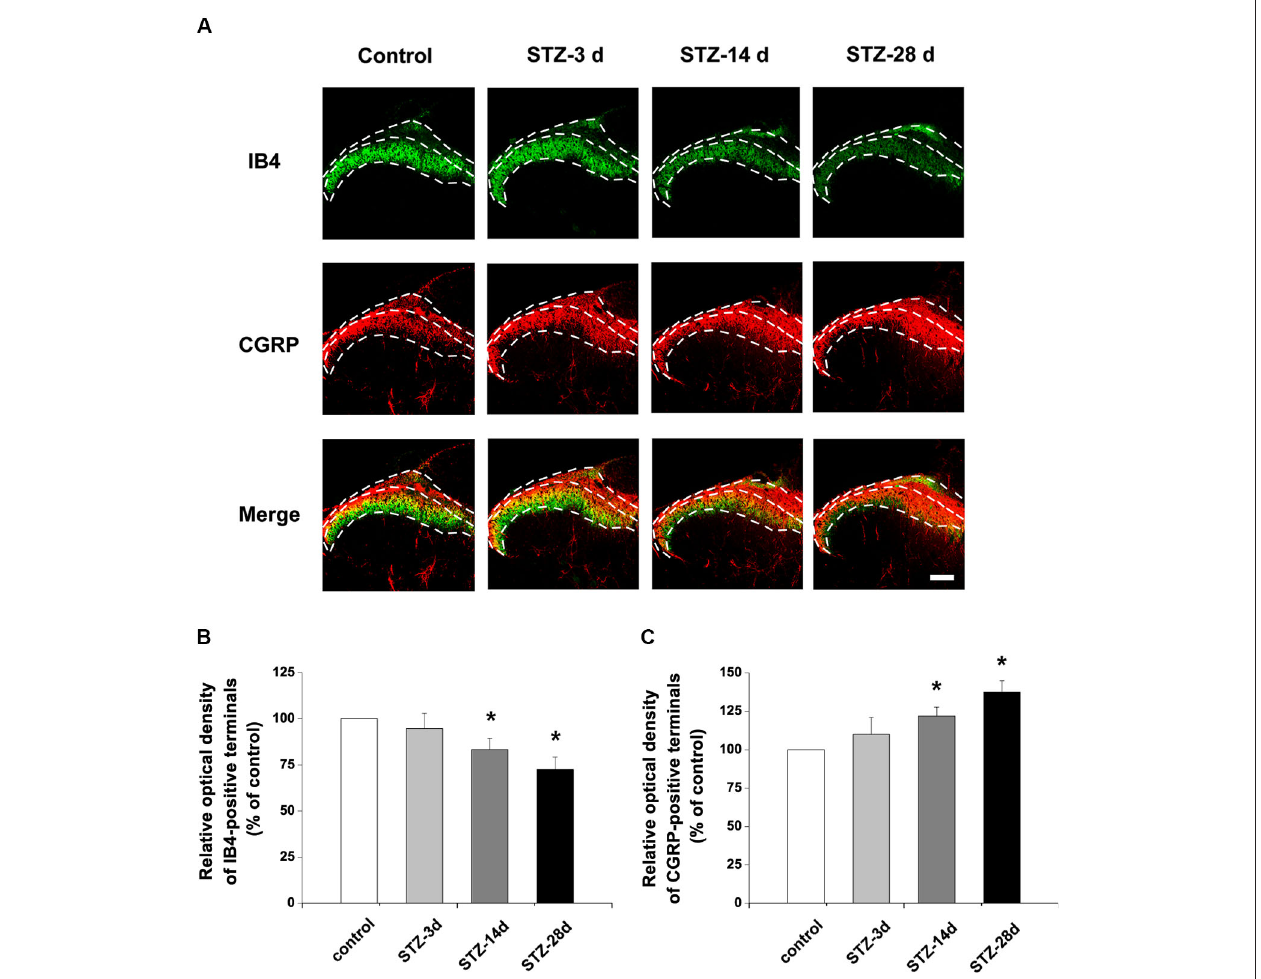
100 µ m. Statistical analyses of the expression of IB4 (B) and CGRP (C) in different groups. Values are normalized, with the mean of the control group set as 100%. Mean ± SD, n = 6 rats in each group. * P < 0.05, comparing diabetic rats with non-diabetic control